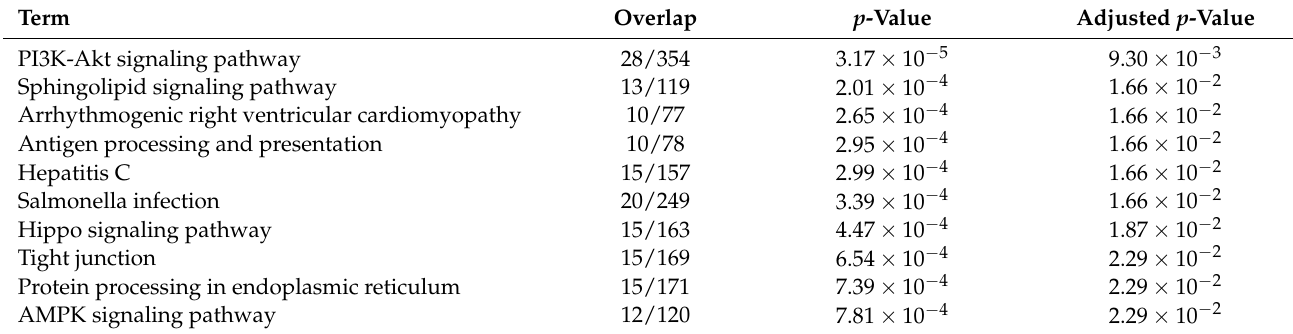
Table 9. The top 10 enriched terms in “KEGG 2021 Human” using Enrichr. Overlap is the number of common genes between the genes uploaded and the genes in the category divided by the number of genes in the category. Probes, whose associated genes were uploaded to Enrichr, were identified using linear